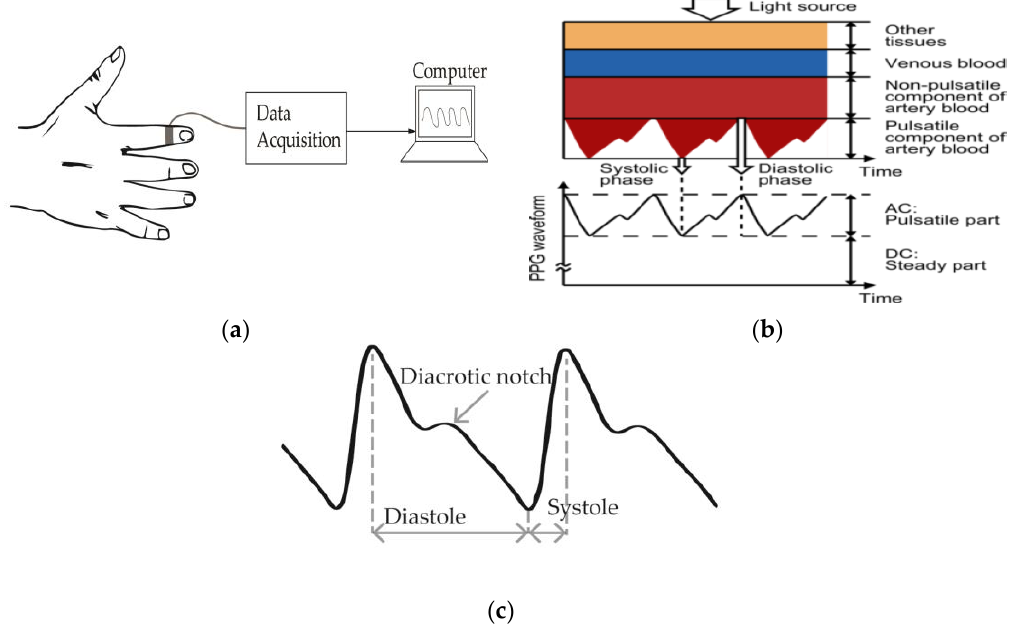
Figure 2. ( a ) Photoplethysmogram (PPG) measurement setup; ( b ) effect of light on different tissues of human body [37]; ( c ) description of PPG waveform.